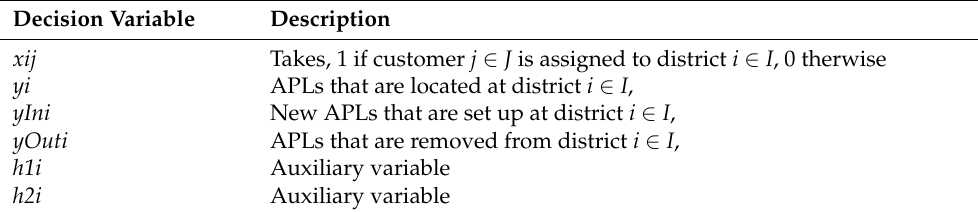
Table 1. Model decision variables.